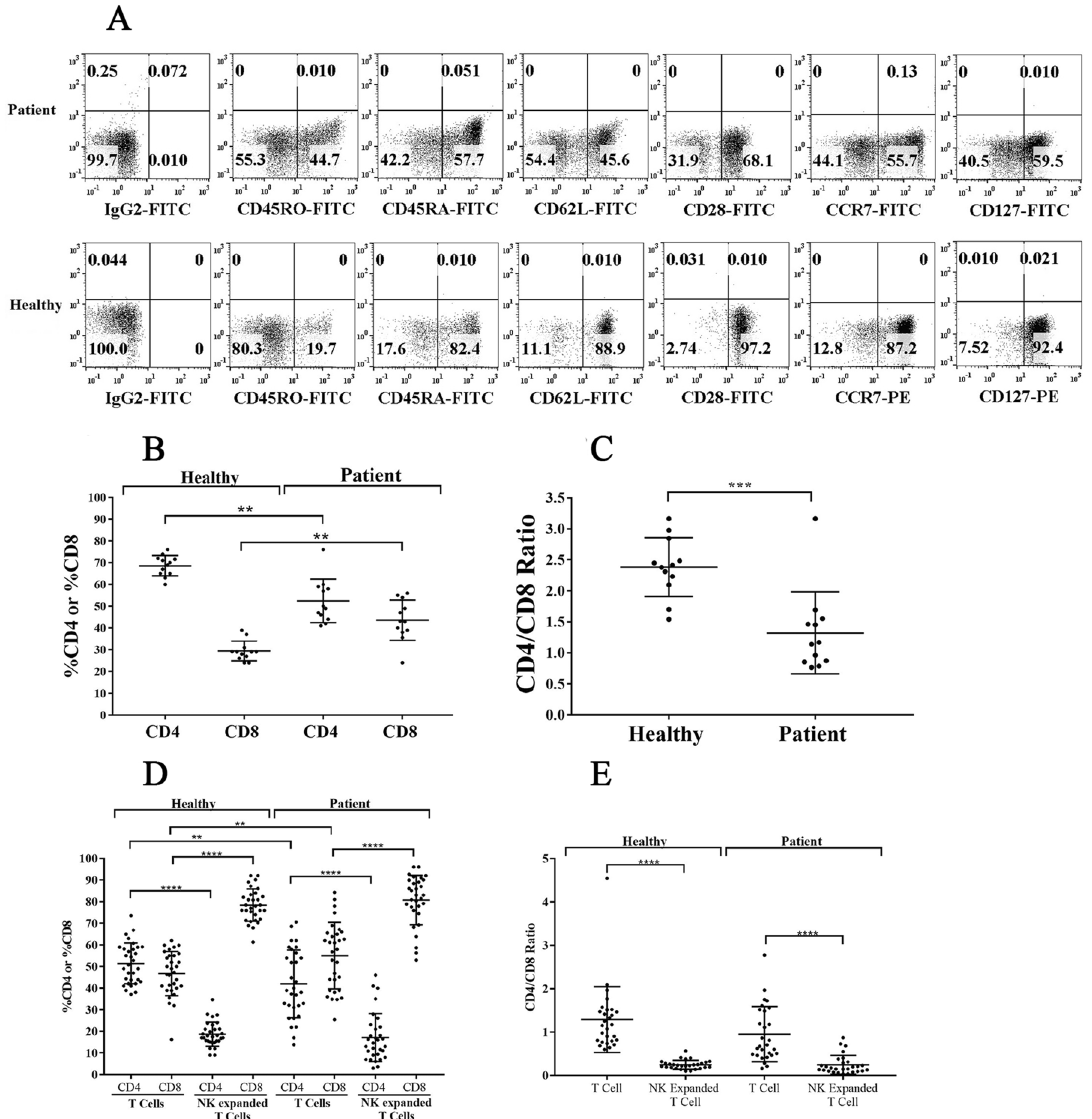
Figure 3. T cells from cancer patients exhibit lower CD4 + /CD8 + T cell ratio both in peripheral blood and after expansion. T cells purified from PBMCs of healthy individuals and cancer patients were analyzed for the surface expression of CD45RO, CD45RA, CD62L, CD28, CCR7, and CD127 using flow cytometry. IgG isotype control was used to assess non-specific binding. One of 12 representative experiments is shown in the figure (A) . PBMCs isolated from the peripheral blood of healthy individuals and cancer patients were used to determine the surface expression of CD4 and CD8 using flow cytometry, and the percentages of CD4 + and CD8 + T cells were determined within CD3 + populations (n = 12) (B) . The ratio of CD4:CD8 is shown in the figure (n = 12) (C) . NK and T cells of healthy individuals and cancer patients were treated and co-cultured as described in Fig. 1A and Fig. 1E respectively. On days 6, 9, 12, and 15 of co-culture, the surface expression of CD4 and CD8 were analyzed by flow cytometry to obtain the percentages of CD4 + and CD8 + T cells within CD3 + populations (n = 28) (D) . The ratio of CD4:CD8 is shown in the figure (n = 28) (E) with autologous OCs (Fig. 2E–G). These results indicated severe functional defects in both NK cells and OCs of cancer patients. OC‑induced T cell mediated expansion increased CD8+ T cells moderately when compared to OC‑induced NK cell mediated expansion of CD8+ T cells. We next analyzed the surface phenotype of memory and naïve subpopulations of T cells, and observed increase in CD45RO+ cells (activated T cells) and decrease in CD45RA+ cells (naïve T cells) on cancer patients’ T cells (Fig. 3A). We also noted reduced surface expressions of CD62L, CD28, CCR7, and CD127 on cancer patients’ T cells (Fig. 3A). Moreover, percentages of CD4+ T cells were decreased with corresponding increase in the percentages of CD8+ T cells in cancer patients’ PBMCs (Fig. 3B). Accordingly, we observed decreased CD4+ /CD8+ T cell ratios in cancer patients’ PBMCs,